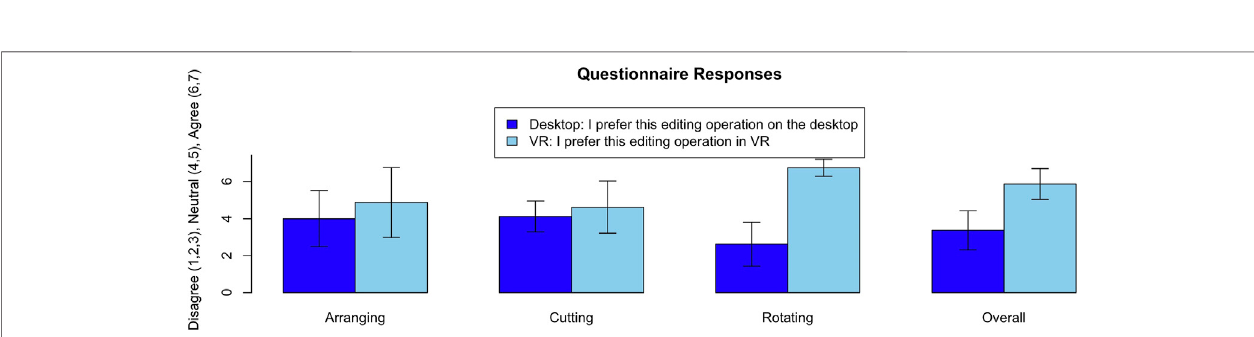
FIGURE 14 | Mean responses to the fi nal questionnaire for each of the three